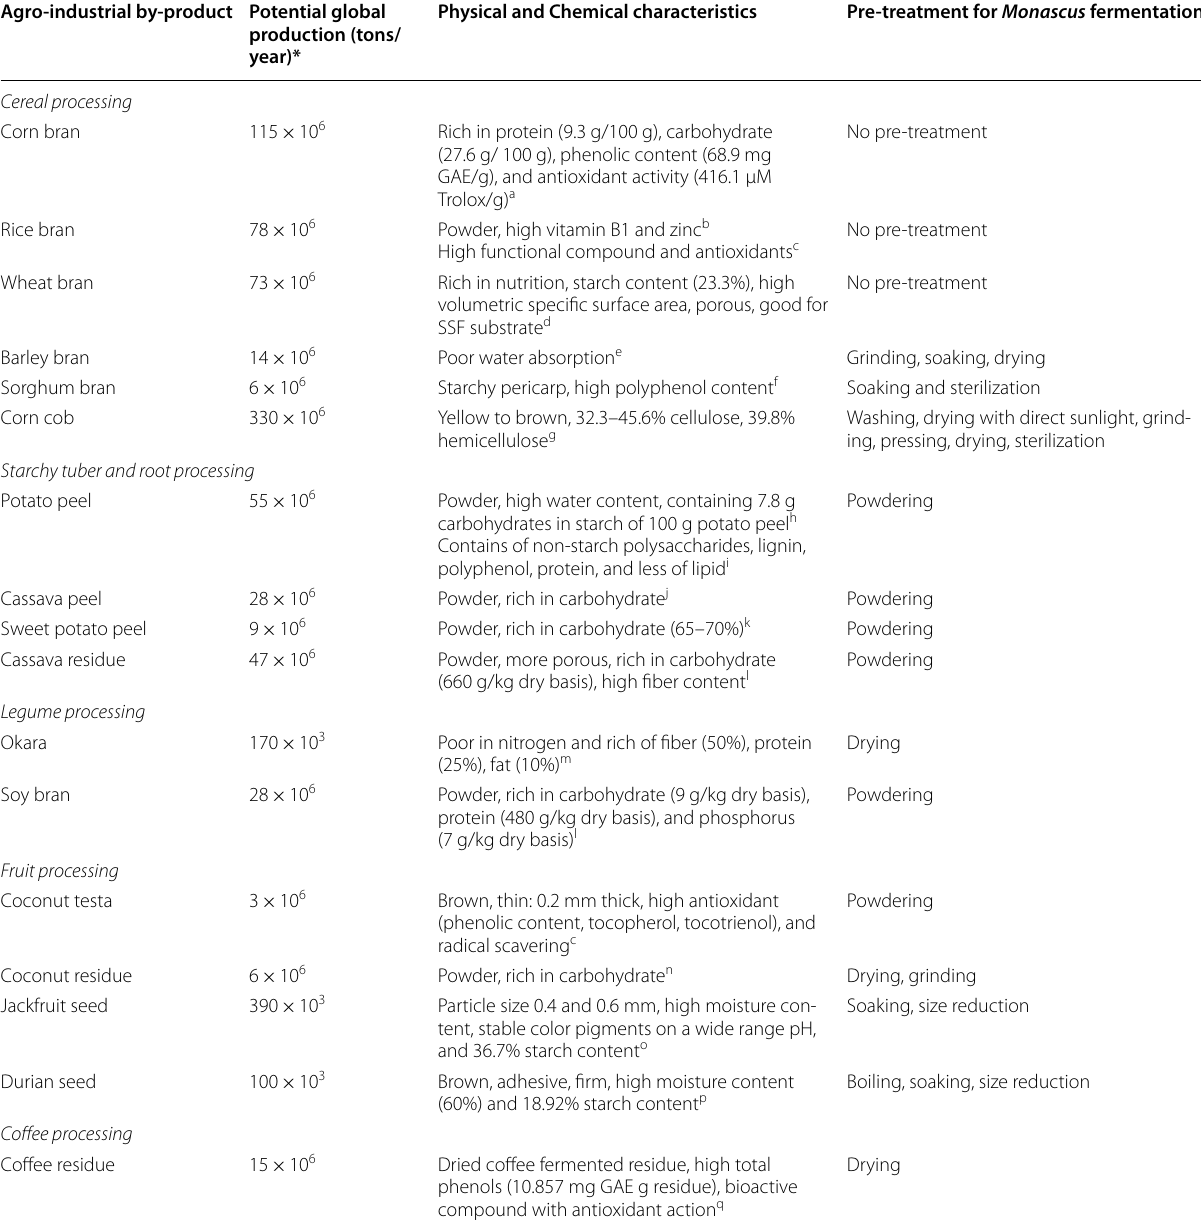
Table 1. Agro‑industrial by‑products production, characteristics, and pre‑treatment for Monascus fermentation Agro-industrial by-product Potential global production